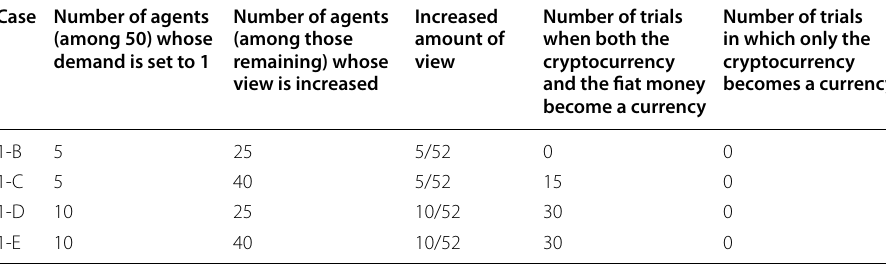
Table 1 Introduction of the cryptocurrency payment cases (the cryptocurrency good is not selected as a utility)